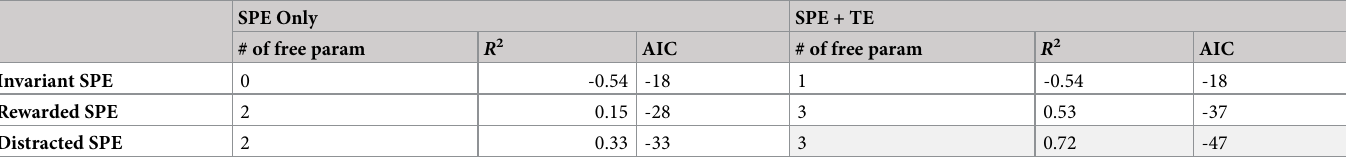
Sampling a wider range of target jumps also allowed us to fit our candidate models to the data (see formalization in Table 3 of the Materials and Methods section). In doing so, we could quantitatively evaluate how well our six candidate models fit the data while considering model complexity. Consistent with the qualitative assessments described above, the Distracted SPE + TE model provided the best fit, having the highest R 2 and lowest AIC (Table 4). The modeling work also allowed us to evaluate the best fitting parameters of the Distracted SPE + TE model. The parameter values suggest that TE may contribute to learning. Given the estimated slope ( β ) of the TE function was 0.02 ± 0.003, we can infer that, of the 0.5˚ change TE in hand angle observed for the 3˚ no-jump condition (where both SPE and TE are present), 12.0% ± 1.8% of the change came from TE. Similarly, when the error increased to 7˚ in a no- jump condition, 15.5% ± 2.8% of the 0.9˚ change in hand angle came from TE. Importantly, these results indicate that SPE has a much larger impact on implicit recalibration than TE. The Distracted SPE + TE model has two parameters to capture the effects of perturbing the target. First there is a fixed effect arising from the transient changes that occur when the target is perturbed. The estimate of this parameter ( C ) in the best fitting model was 0.84 ± 0.13. Thus, J the mere perturbation of the target, even if it was not spatially displaced reduced recalibration by 16.4% ± 13.0%. Second there is a variable cost ( s 2 ) due to SPE-based learning being attenu- d ated as the target jump distance increased. The estimate of this parameter was 11.8 ± 2.3. From this value, SPE would no longer be effective in driving implicit recalibration for target jumps greater than 35.5˚ ± 6.8˚ (i.e., 3 s 2 ). d